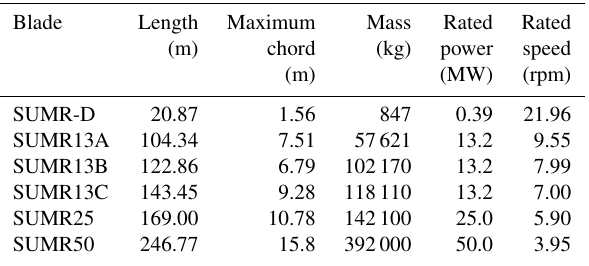
Table 2. Geometry and operating specification of the two-bladed wind turbine blade models examined in the study. The blades are sorted by blade